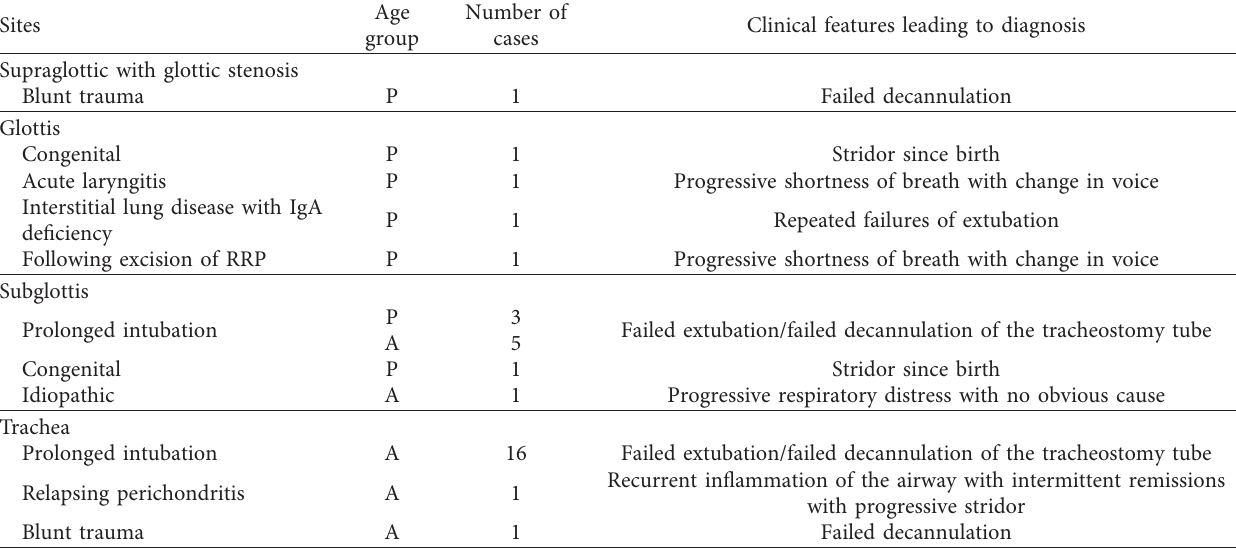
Table 3: Aetiology of airway stenosis according to age distribution and clinical features.